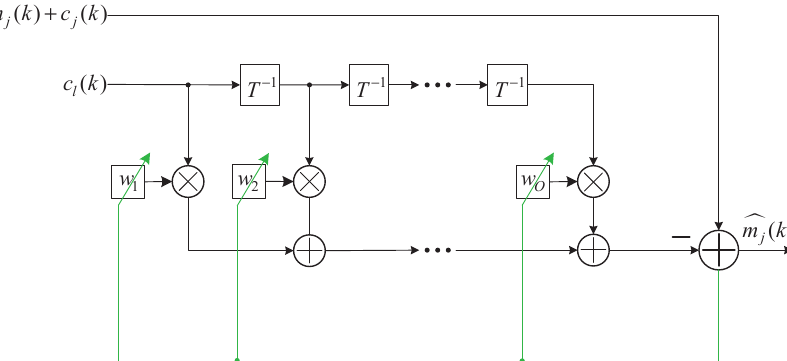
Figure 4. Structure of the adaptive filter. x j ( k ) is the EMG–ECG mixture in the j th channel, c l ( k ) is one of the nine ECG leads in the same dataset as c j ( k ) but was not used for mixing, T − 1 indicates a one-sample delay, and O is the filter